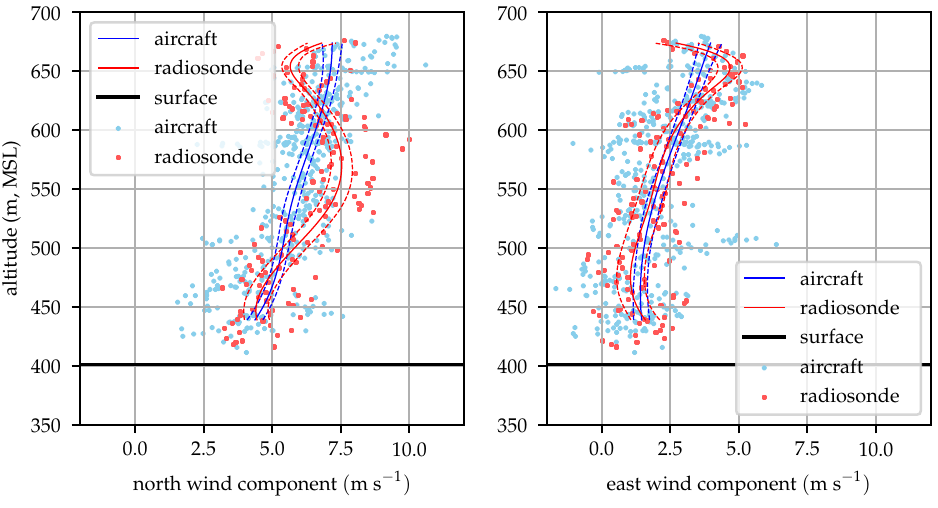
Figure 17. Aircraft and radiosonde profiles from 16:00 local time